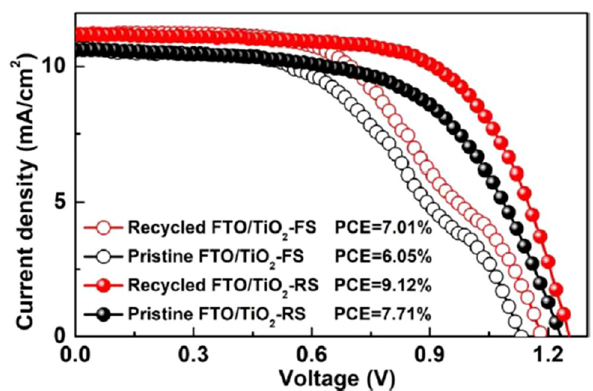
Figure 49: J – V curves and PCE values of the prepared Co/MnO 2 – PC hybrid; inset illustrates the concept of multiple electron di ff usion routes for I 3 − reduction. Copied with permission from ref. [ 478 ] ; Elsevier,